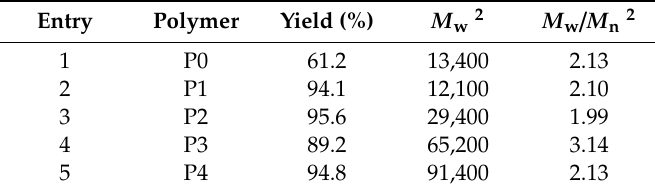
Table 1. Polymer Reactions of P 0 and other precursors with pyrene-methylamine 1